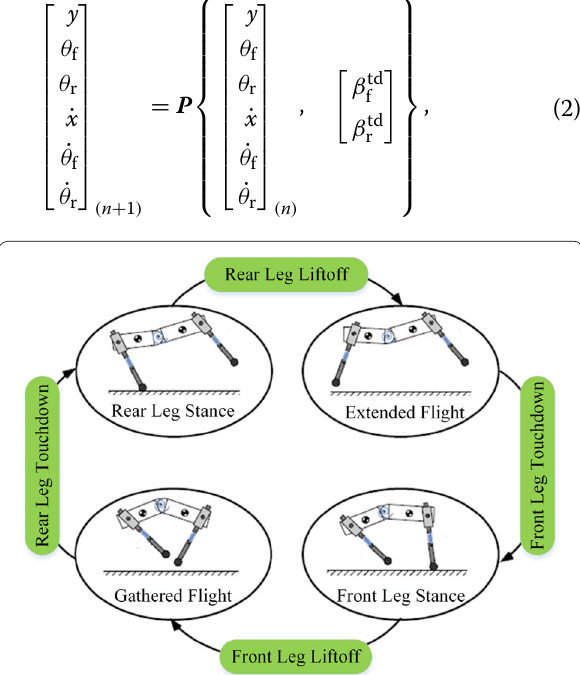
Figure 2 Phases of the passive periodic